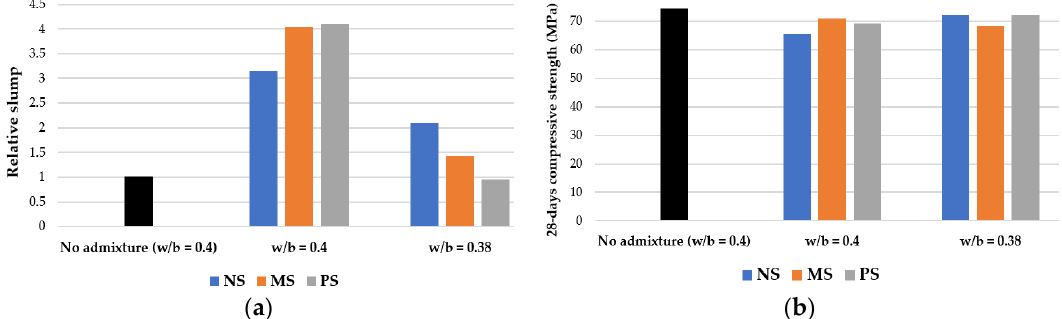
Figure 9. Influence of admixture type and w/b ratio on slump ( a ) and mechanical strength ( b ) (adapted from [38]).